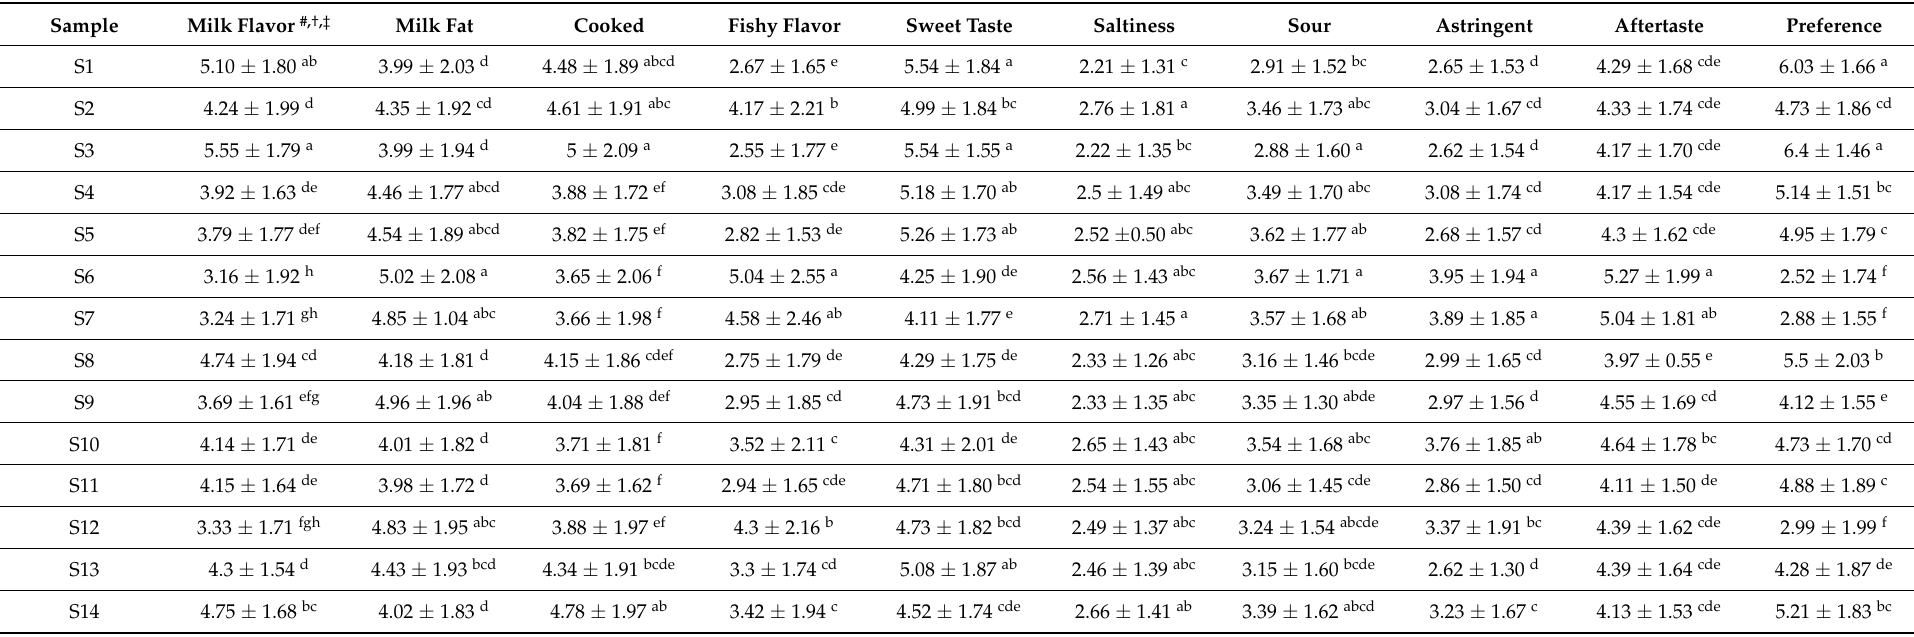
Table 3. Significance analysis of sensory evaluation results (mean and standard deviation, SD of milk powder